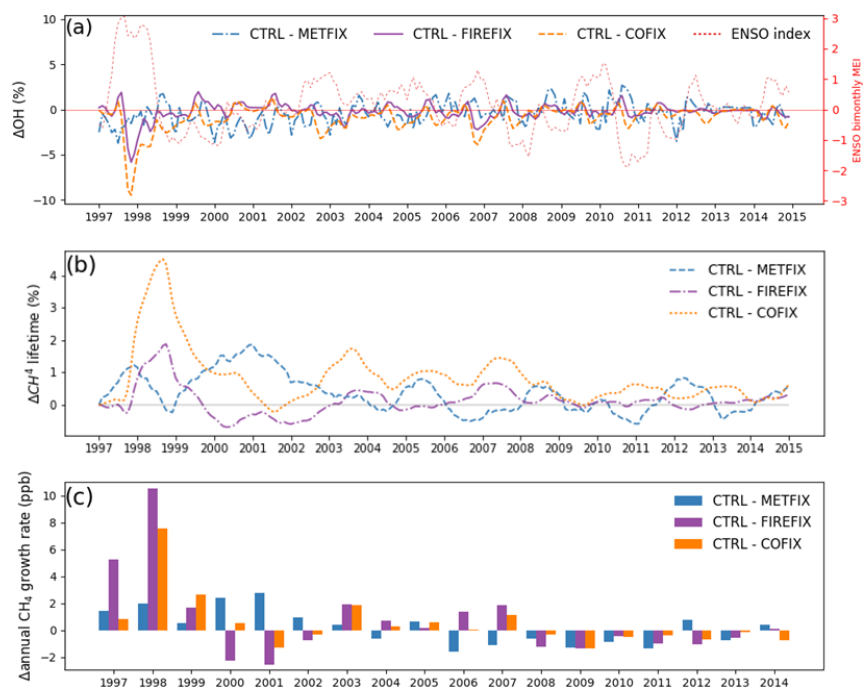
Figure 7. Time series of (a) the change (%) in mass-weighted tropospheric OH, (b) change (%) in CH 4 lifetime and (c) resultant change (ppb) in annual CH 4 growth rate calculated using an offline box model. The ENSO bimonthly mean multivariate index is plotted with the dashed red line using the right-hand y axis in (a)